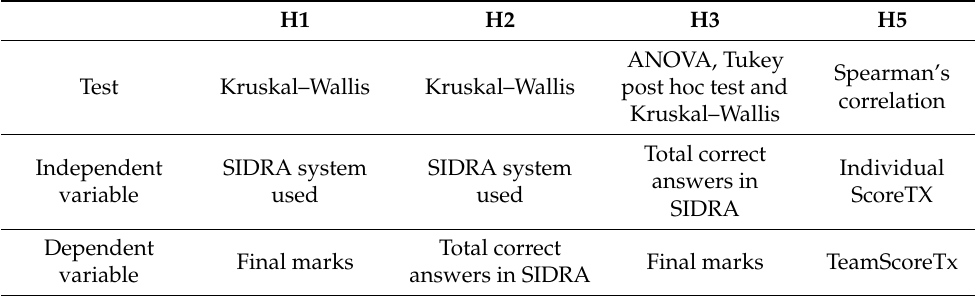
Table 2. A Summary of the Statistical Treatments Performed for Each Hypothesis. H1 H2 H3